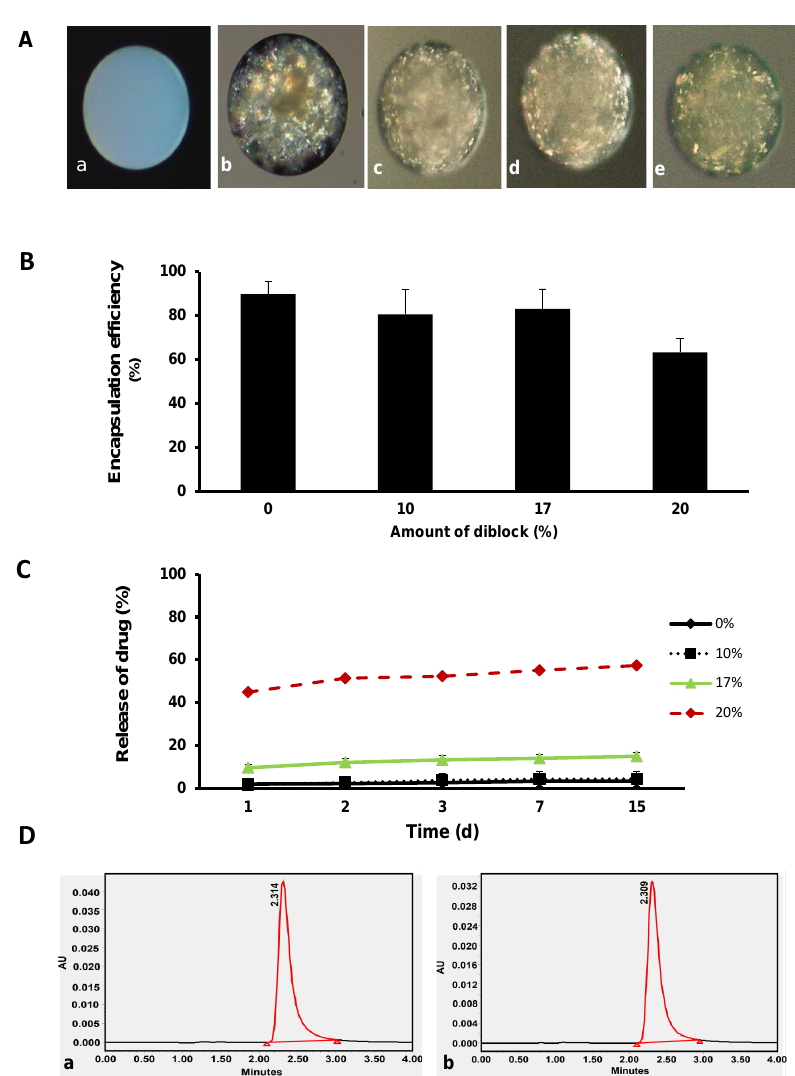
Figure 2. Encapsulation efficiency, in vitro drug release profile from the microspheres, and stability of KynA in the process of encapsulation ( A ) Polarized light microscopy images of empty ( a ),